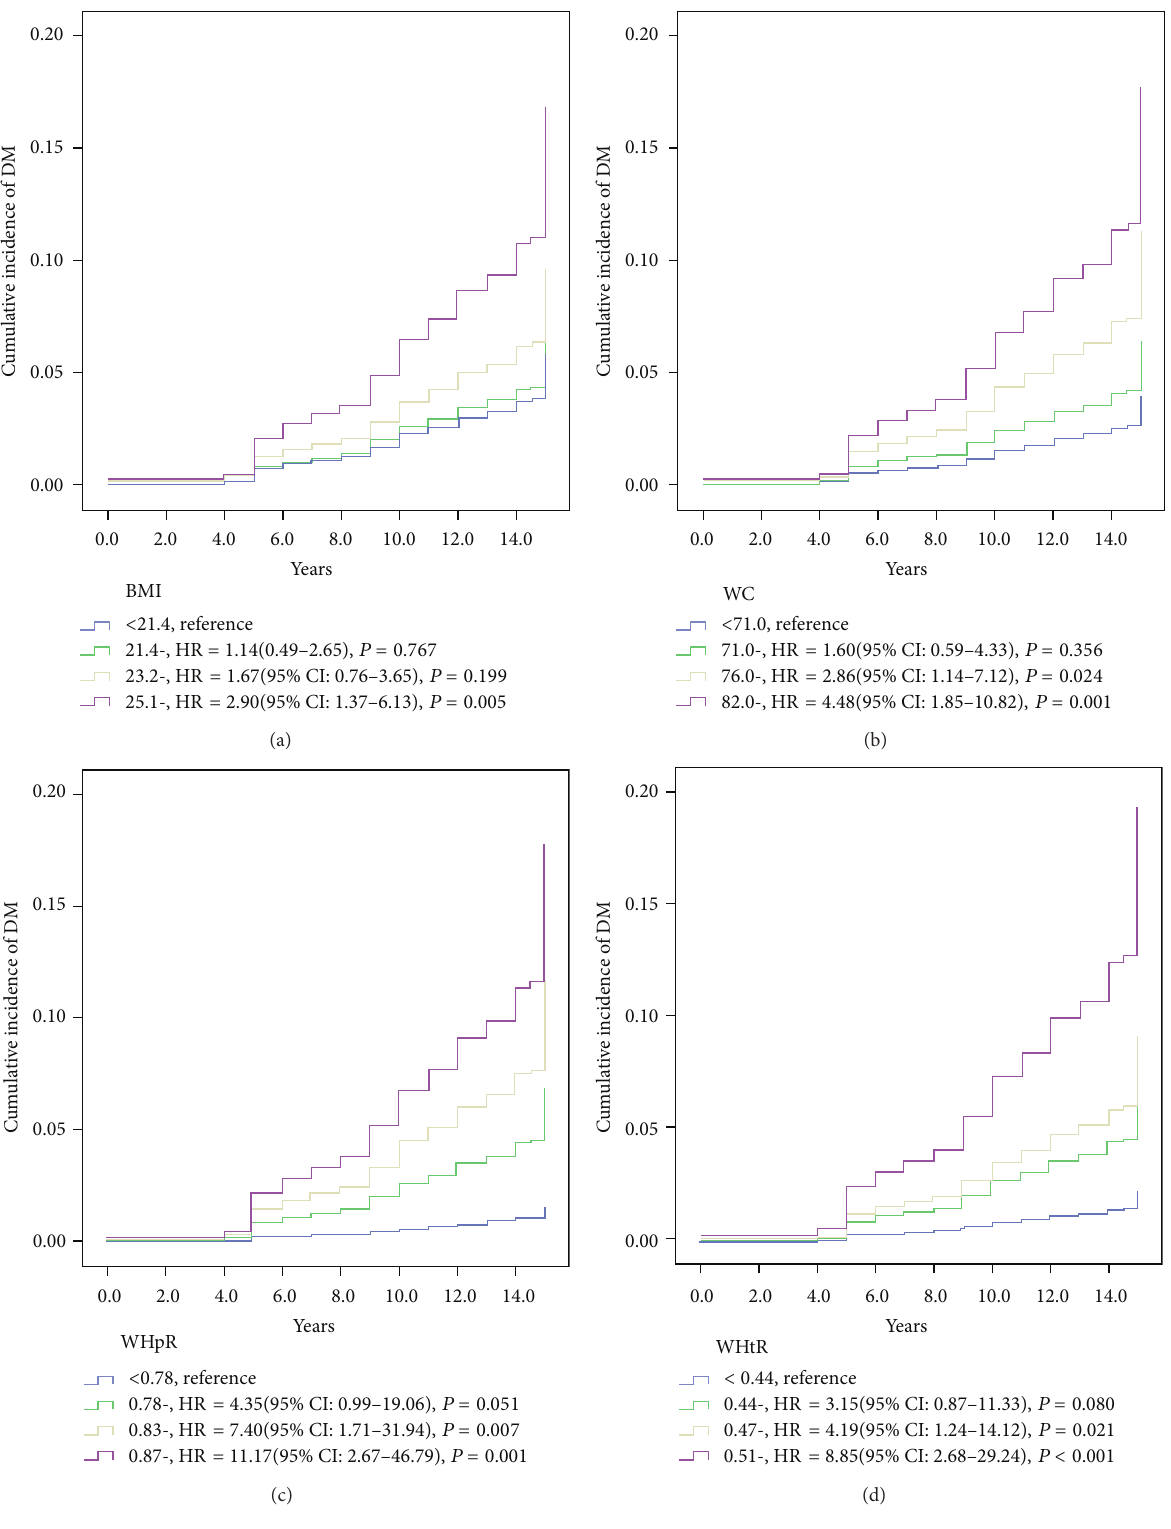
Figure 2: Cumulative incidence of DM in different anthropometric variables groups in multivariate COX-regression in Model 2. Model 2 adjusted for age, sex, smoking, alcohol intake, regular physical exercise, family history of diabetes, SBP, HDL, TG, and FPG. SBP = systolic blood pressure, HDL-C = high density lipoprotein cholesterol, TG = triglyceride, and FPG = fasting plasma